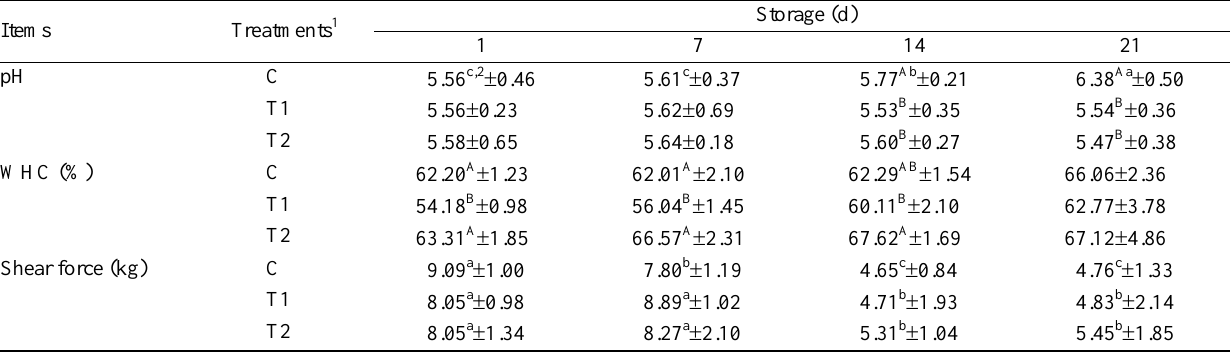
Table 1. Effects of packaging and aging methods on the pH, WHC, and shear force of low-grade beef during storage